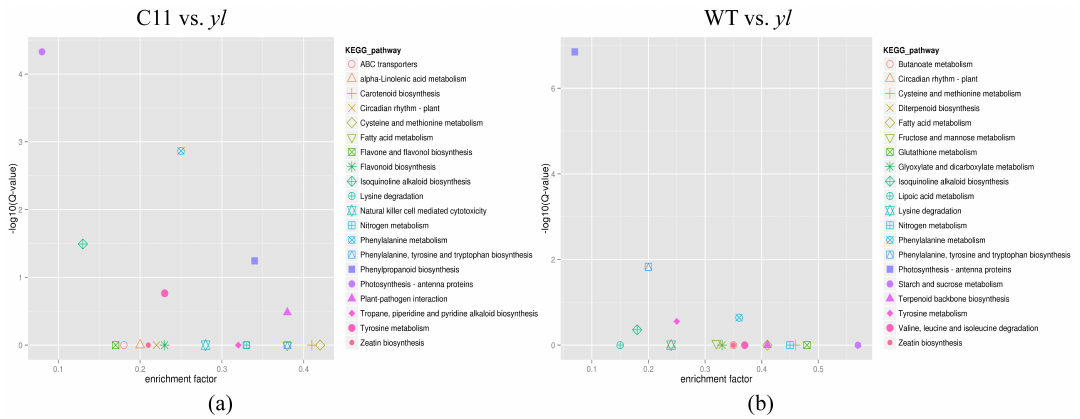
Figure 6. KEGG-based pathway enrichment of DEGs in C11 vs. yl and WT vs. yl .